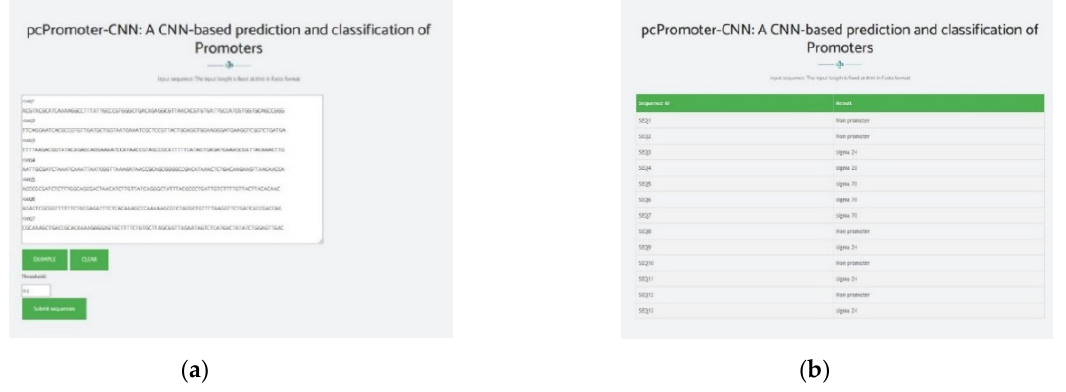
Figure 5. Webserver. ( a ) Insertion of sequences for prediction. ( b ) Predictor output.